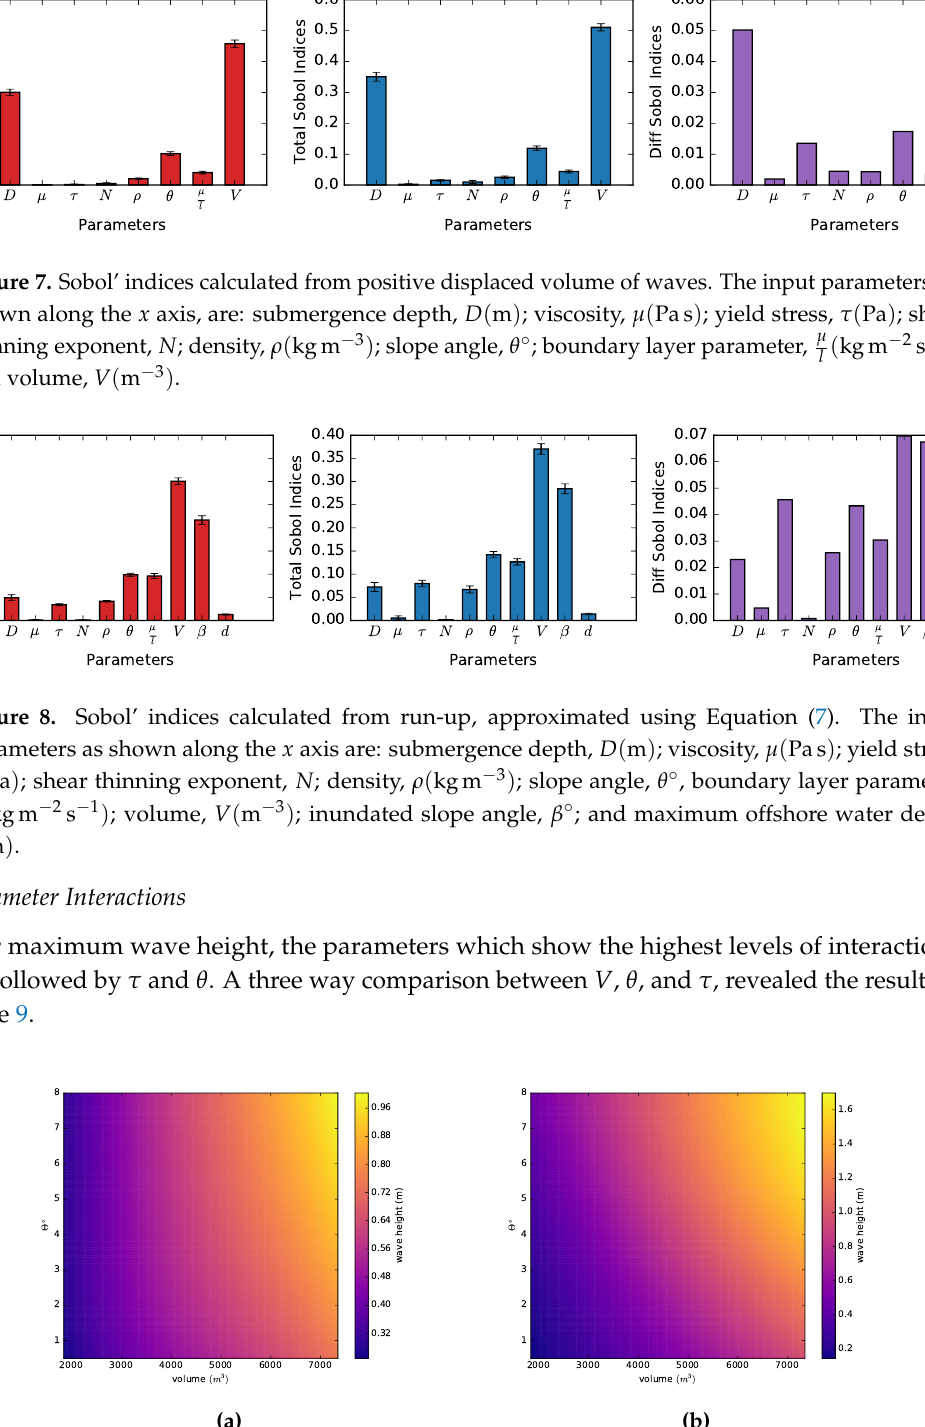
Figure 9. Volume, slope angle, and yield stress three way comparison. Yield stress is decreasing from left to right. Volume and slope angle were sampled throughout their ranges, and all other parameters were fixed at their mean values. ( a ) Maximum wave height predicted by the emulator for given volume and slope angle and maximum yield stress. ( b ) Maximum wave height predicted by the emulator for given volume and slope angle and minimum yield